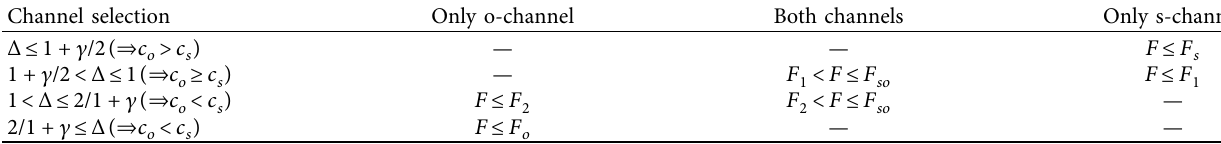
Table 1: The optimal strategy in different